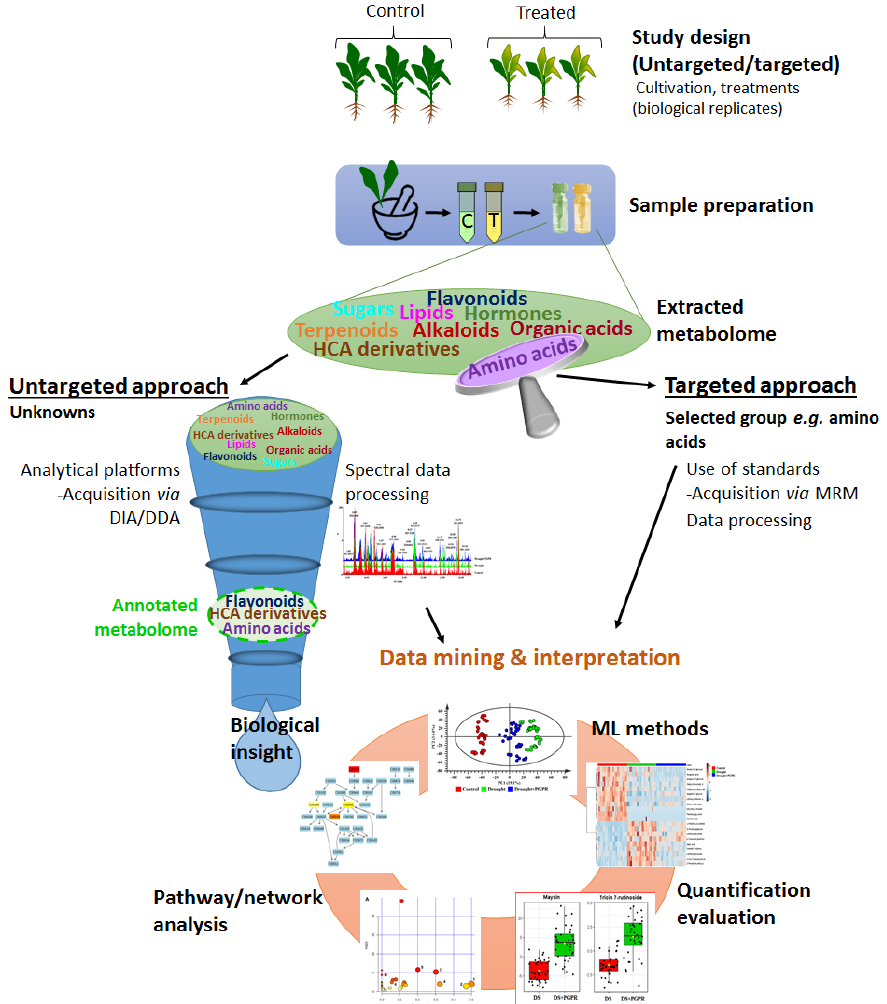
Figure 4. A schematic representation of a metabolomics workflow. The infographics depicts key components in the multistep mass spectrometry-based (plant) metabolomics workflow pipeline, which include study design (untargeted/targeted), sample preparation, data acquisition, mining and interpreting metabolomics data. Abbreviations: DIA = data independent acquisition, DDA = data dependent acquisition, ML = machine learning.